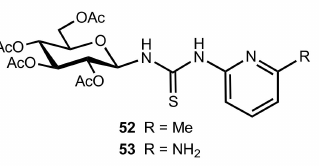
Figure 6. The structure of organocatalysts 52 and 53